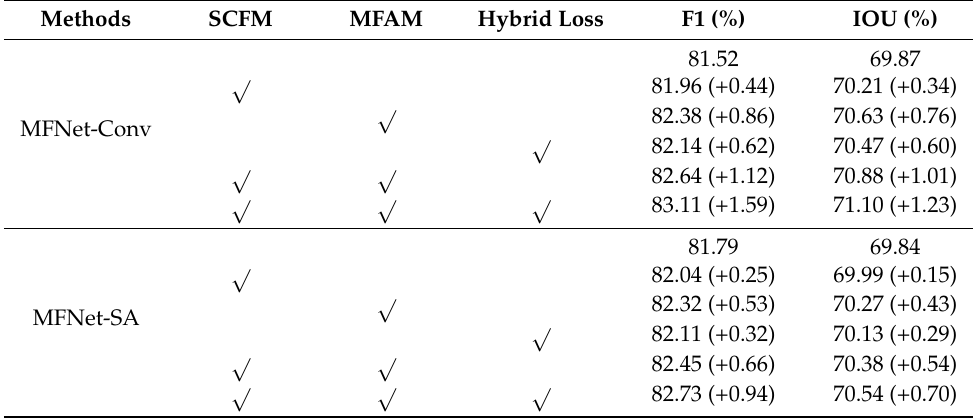
Table 5. Results of MFNet ablation experiments on the SYSU-CD